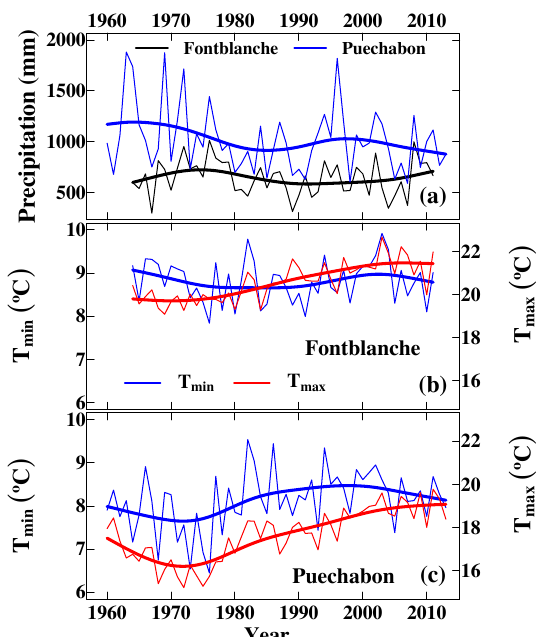
Figure A1. Mean climatic time series of the last 50 years. (a) Annual precipitation; and annual maximum ( T max ) and minimum ( T min ) temperatures for Fontblanche (b) and Puechabon (c) .